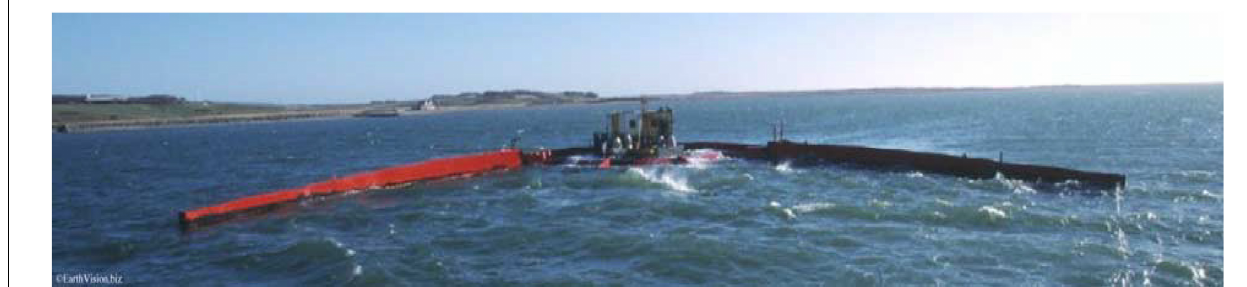
FIGURE 3 | Wave Dragon (Kofoed et al., 2006).